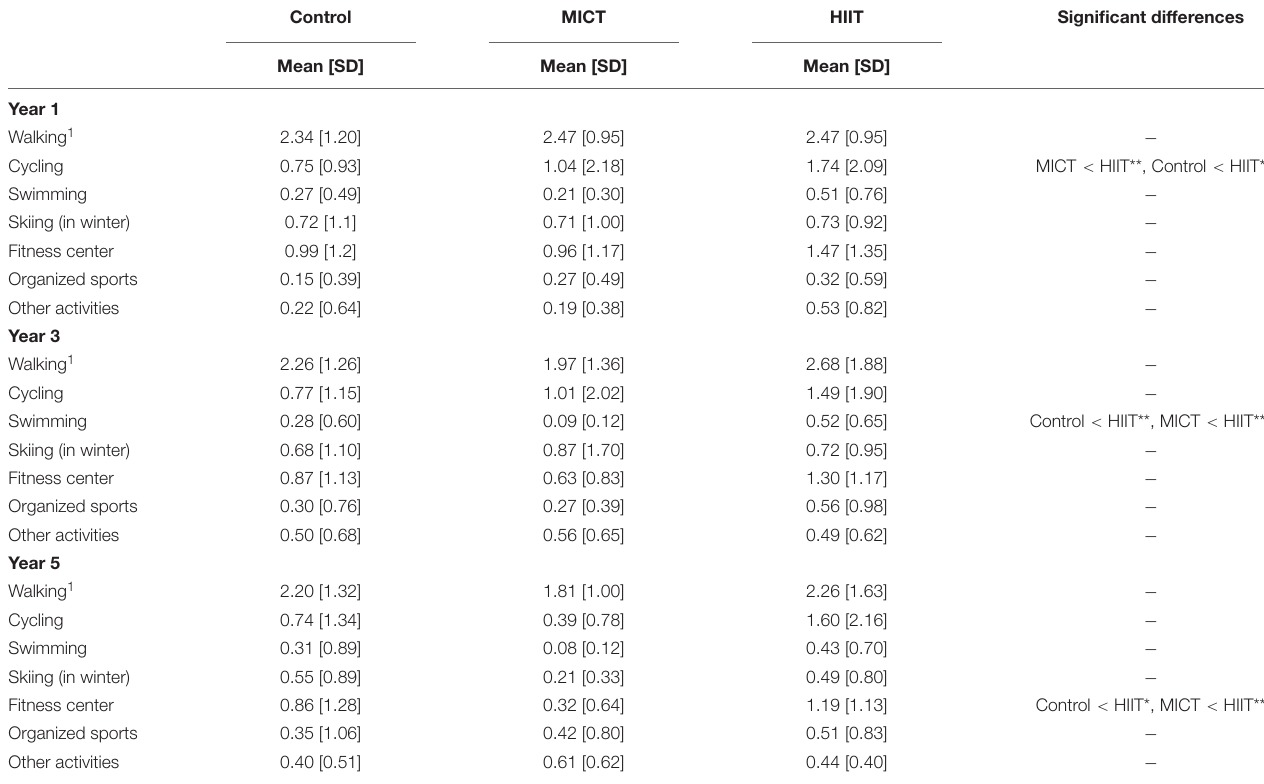
TABLE 5 | Exercise types and weekly frequency in the control, moderate-intensity continuous training, and high-intensity interval training groups throughout the